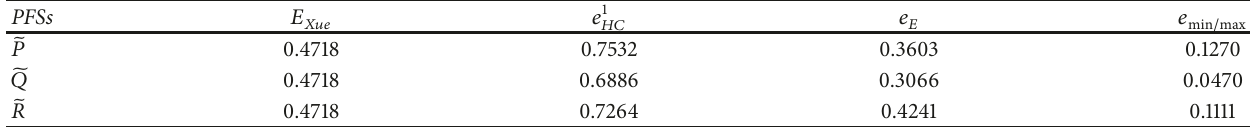
Table 4: Degree of fuzziness from entropies of different